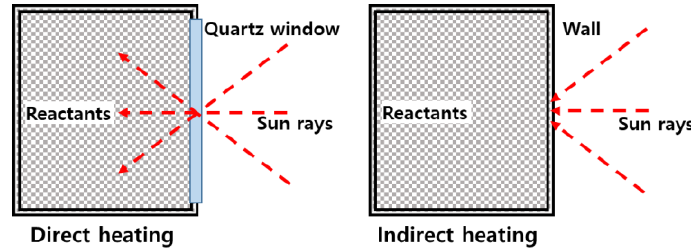
Figure 1. Direct and indirect heating